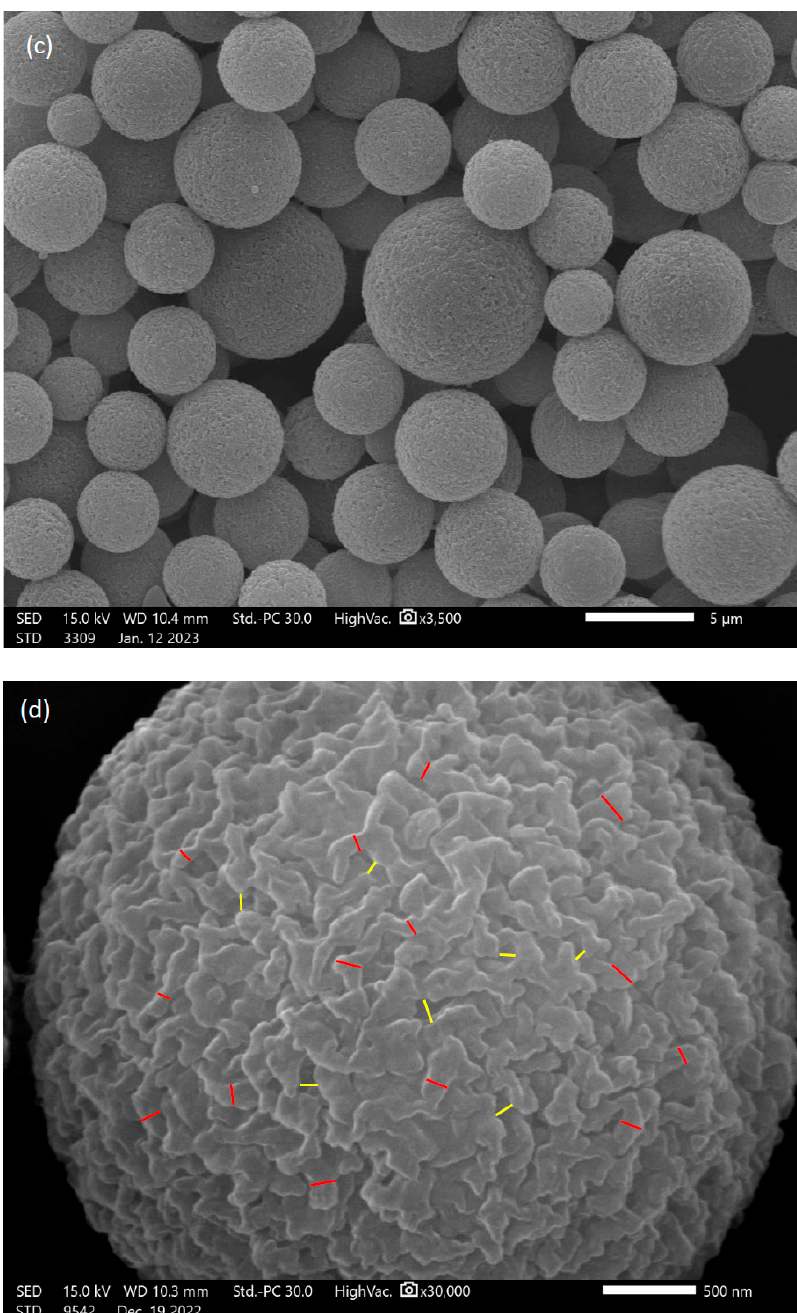
Figure 1. Scanning electron microscopy (SEM) pictures of the evaluated column materials. ( a ) poly(SPE-co-EDMA) monolithic stationary phase, ( b ) poly(SPE-co-MBA) monolithic stationary phase, ( c ) ZIC-pHILIC particles and ( d ) close-up of particle surface. Red lines in ( a , b ) indicate the size of d glob and yellow lines the size of d tp . Red lines in ( d ) indicate the ‘skeleton’ sizes of the polymer structure, yellow lines indicate the mesopore sizes.